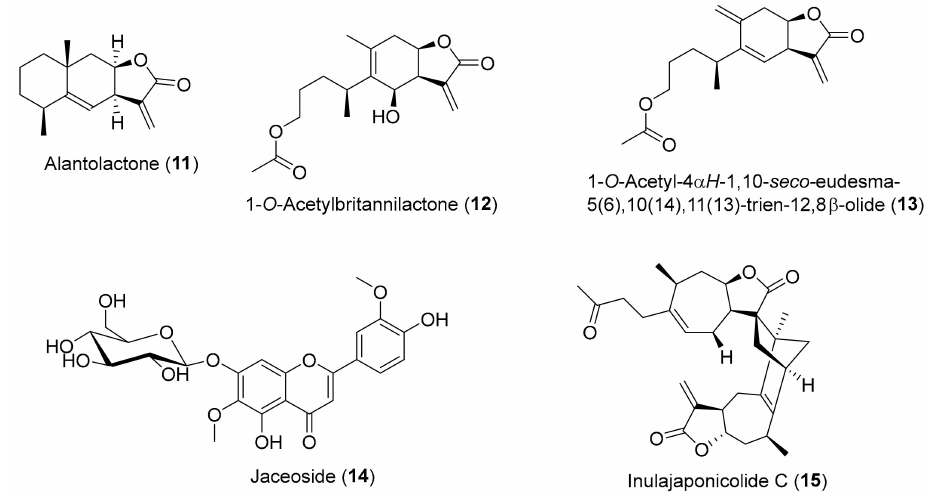
Figure 2. Chemical structure of Inula secondary metabolites ( 11 , 12 , 14 , 15 ) and the semisynthetic derivative ( 13 ) with reported activity against oxidative-stress inflammatory